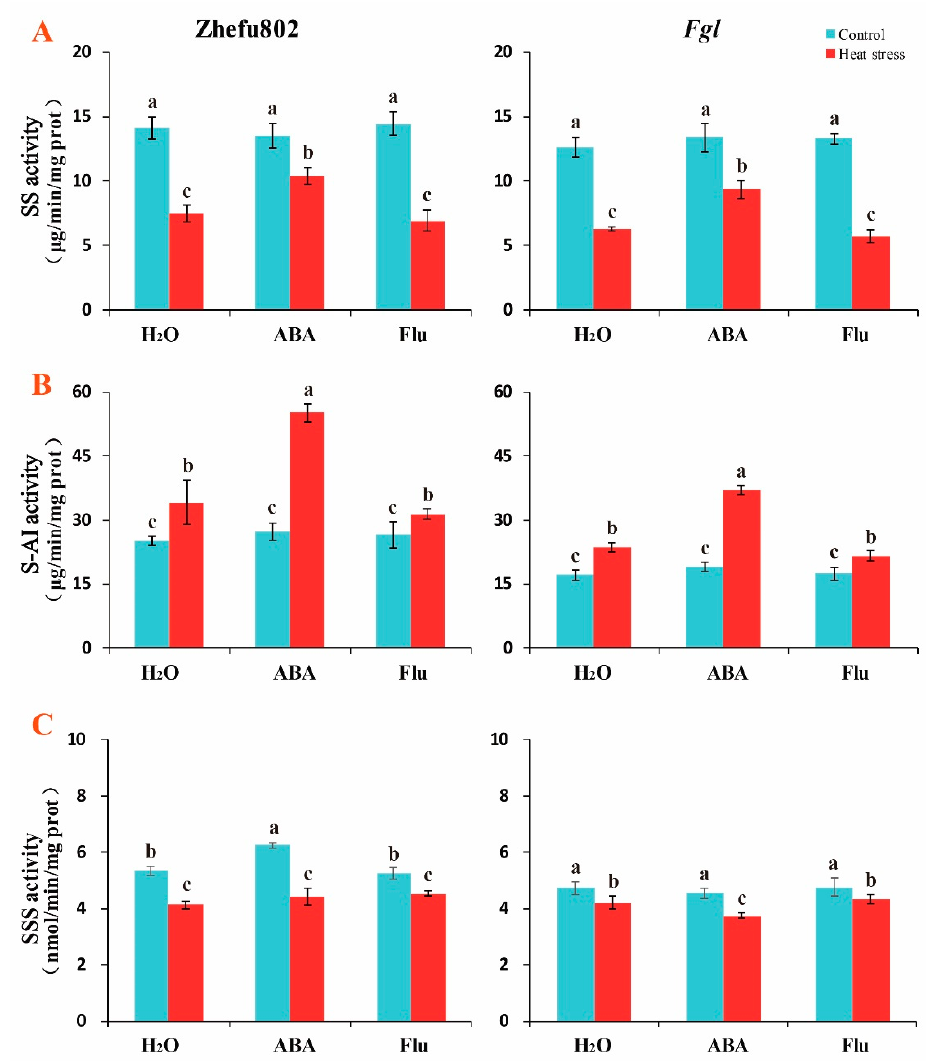
Figure 2. The effects of exogenous ABA on the key enzymes of sugar metabolism in rice plants under heat stress. ( A ), SS activity; SS, sucrose synthase. ( B ), S-AI activity; S-AI, acid invertase. ( C ), SSS activity; SSS, soluble starch synthase. ABA, abscisic acid. Flu, the ABA synthase inhibitor fluridone. Error bars denote standard deviations ( n = 3). Different letters indicate significant differences between the control and heat stress treatments within a genotype by two-way analysis of variance (temperature and treatment) ( p < 0.05).